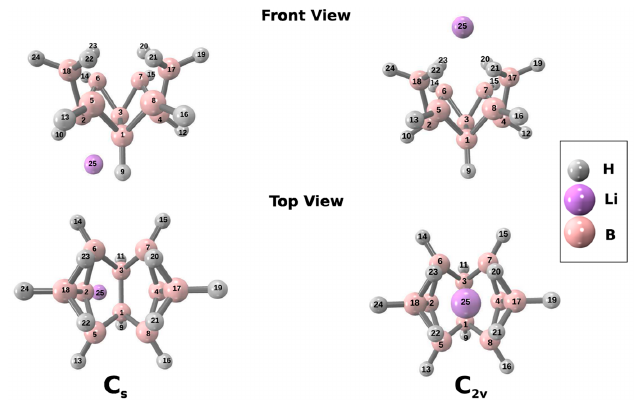
Figure 1. Stable conformers of Li@B 10 H 14 (left, C s conformer and right, C 2v conformer).